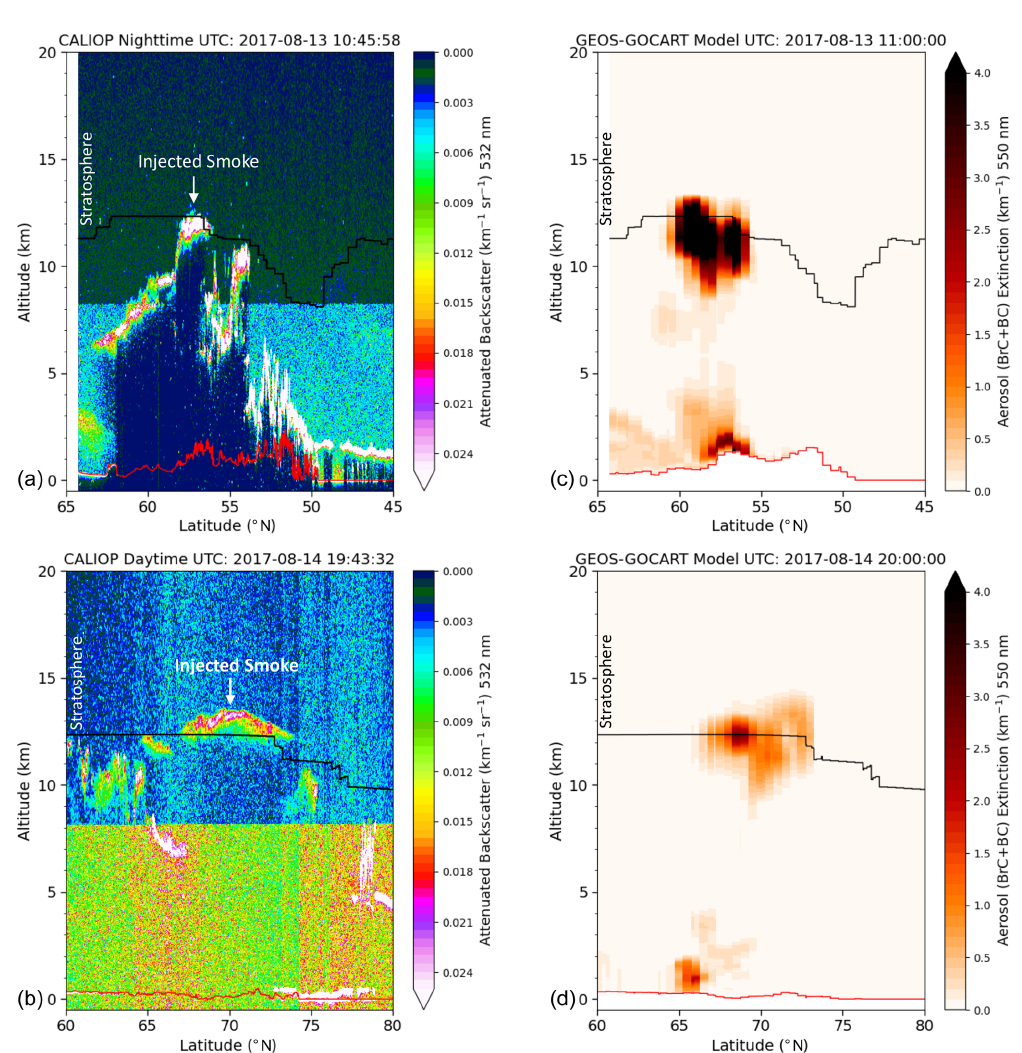
Figure 5. GEOS comparisons along CALIPSO tracks. (a, b) CALIOP-retrieved total attenuated backscatter (km − 1 sr − 1 ) profiles and (c, d) GEOS-simulated smoke aerosol (BrC + BC) extinction (km − 1 ) profiles along the 13 August ∼ 11:00UTC and 14 August ∼ 20 UTC CALIPSO tracks respectively. The red lines depict the surface elevations, and the black lines depict the tropopause heights on each panel. Please note that to reduce the downlink data volume, CALIOP Level 1 profile products are reported at different vertical resolution for different altitude regimes. Since the vertical resolution changes around 8.3km from 30 to 60m, a stark gradient is visible in panels (a) and (b) for altitudes above and below the 8.3km